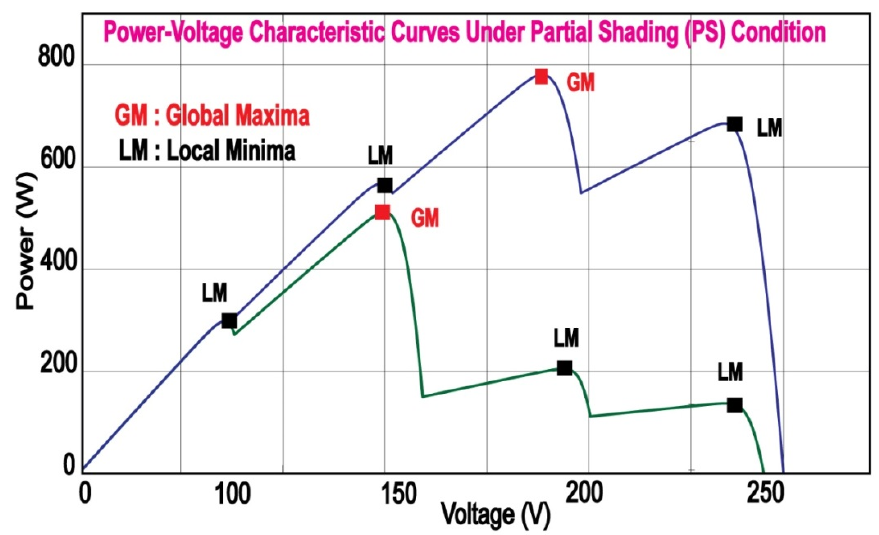
Figure 5. The voltage–power curve under PSC.